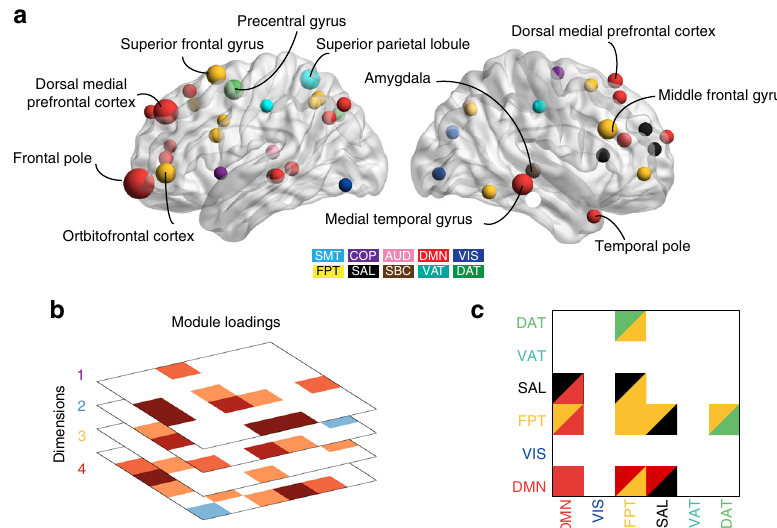
Fig. 6 Loss of segregation between default mode and executive networks is shared across dimensions. a By searching for overlap of edges that contributed signi fi cantly to each dimension, we found common edges that were implicated across all dimensions of psychopathology. These were then summarized at a nodal level by the sum of their absolute loadings. Nodes that contributed signi fi cantly to every dimension included the frontal pole, superior frontal gyrus, dorsomedial prefrontal cortex, medial temporal gyrus, and amygdala. b Results of a similar analysis conducted at the module level. c Loss of segregation between the default mode and executive networks was shared across all four